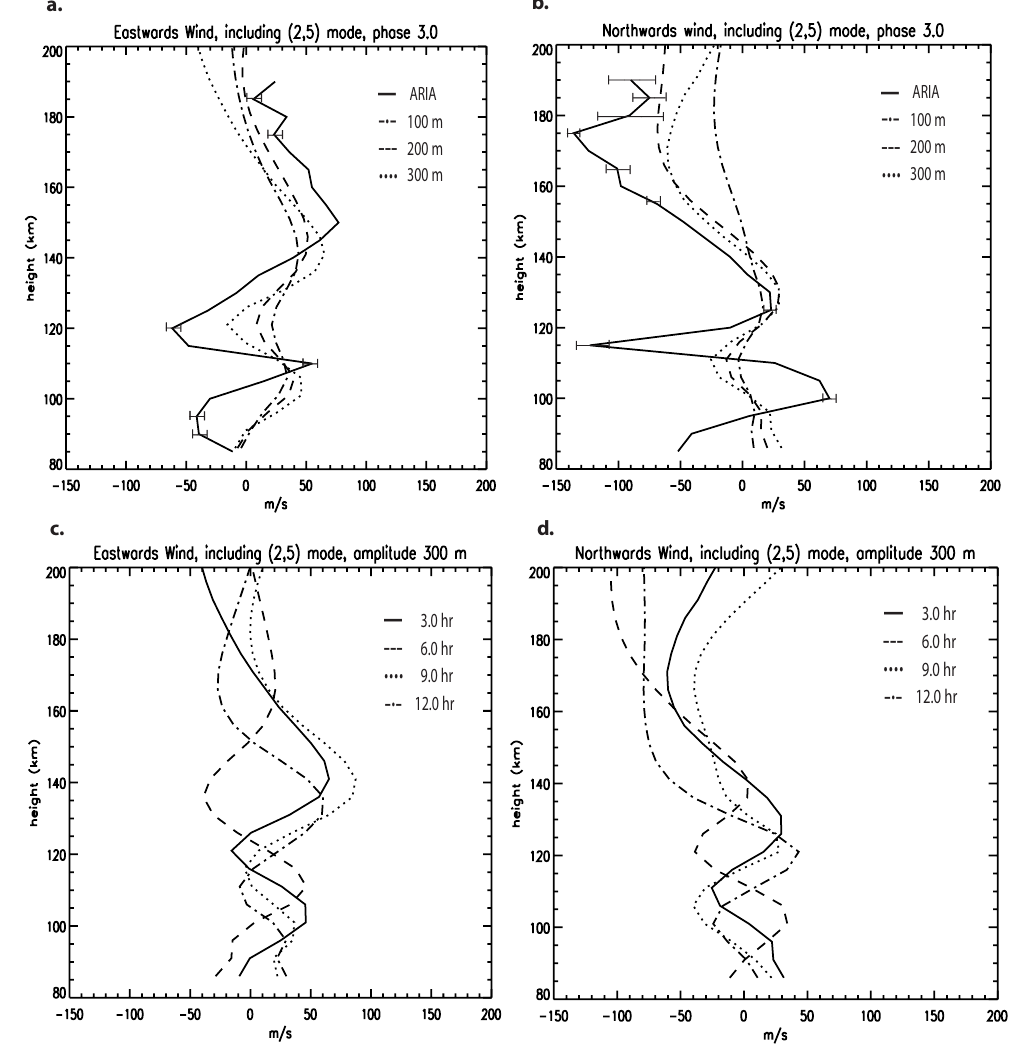
Fig. 2. (a) , (b) Response of the neutral winds to changes in the (2,5) mode tidal amplitude in the background winds compared with ARIA I observations, and (c) , (d) response of the neutral wind to changes in (2,5) mode tidal phase in the background